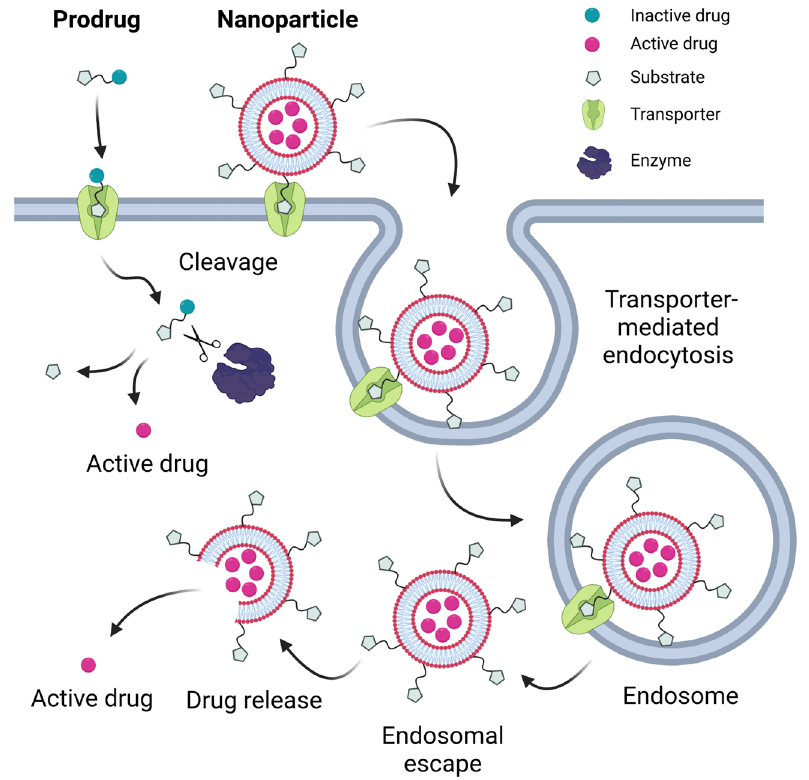
Figure 1. Illustration of the prodrug and functionalized nanoparticle strategies. In the prodrug strat- egy, the deliverable drug of interest is chemically linked to a known substrate of the target transporter. After uptake through the transporter, the chemical link is cleaved by intracellular enzymes, thus freeing the active drug molecule and an inert substrate. In the nanoparticle strategy, known substrates of the target transporter are chemically linked to the nanoparticle, which encapsulates the active drug molecules. Due to the size of the particle, binding to the transporter typically triggers endocytosis. Endosomal escape must occur after cellular uptake to release the content of the nanoparticles, the active drug, into the cytoplasm (see text). Created with BioRender.com. It is often desirable that a drug is not transported into specific cells or across biologi- cal barriers to reduce off-target side effects. For example, first generation H1 histamine